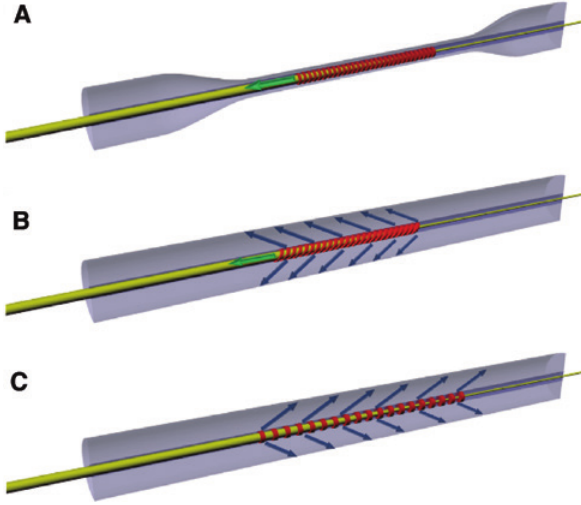
Figure 2: Schematic illustrations of the three different OFGs used for RI sensing along with their respective coupling mechanism sketched with arrows (green: counterpropagating core mode; blue: counter-/co-propagating cladding modes): etched FBG (A), tilted FBG (B), and LPG